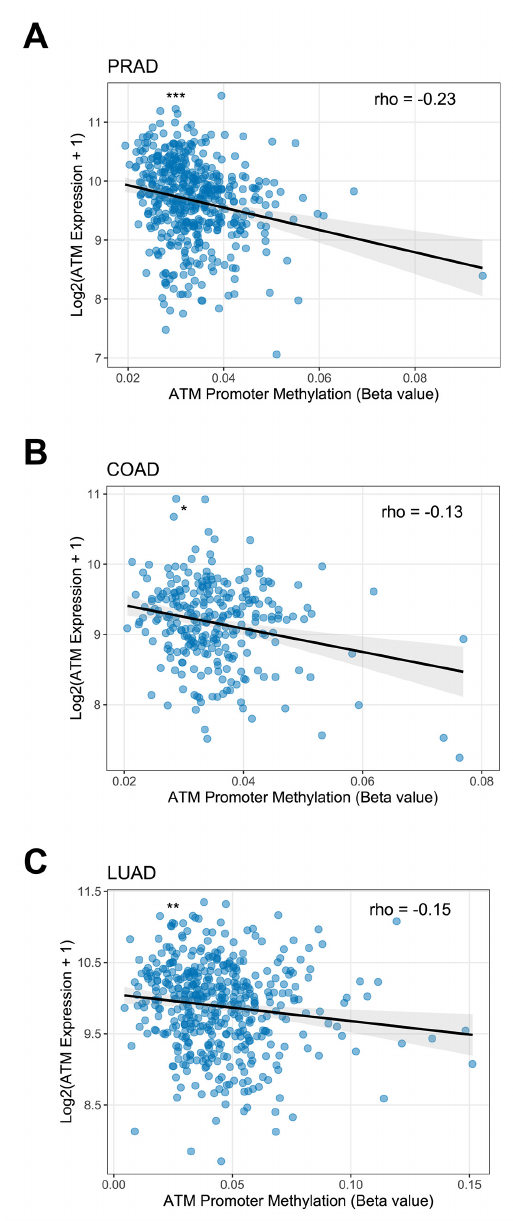
Figure 2. ATM promoter methylation and ATM gene expression in adenocarcinomas. Scatter plots showing the correlation between methylation beta values of the ATM promoter probe cg01756564 and ATM gene expression in TCGA datasets of ( A ) prostate adenocarcinoma (PRAD, n = 496), ( B ) colon adenocarcinoma (COAD, n = 276) and ( C ) lung adenocarcinoma (LUAD, n = 454). Spearman’s rho values are indicated in the top right. Grey region of linear fit indicates 95% confidence interval. Asterisks in the top left indicate significance. * = p < 0.05, ** = p < 0.01, *** = p < 0.001.